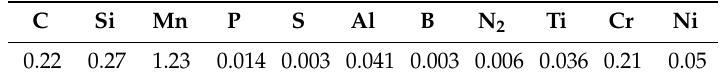
Table 1. Chemical composition of USIBOR 1500P ® (in wt % with balanced Fe). C Si